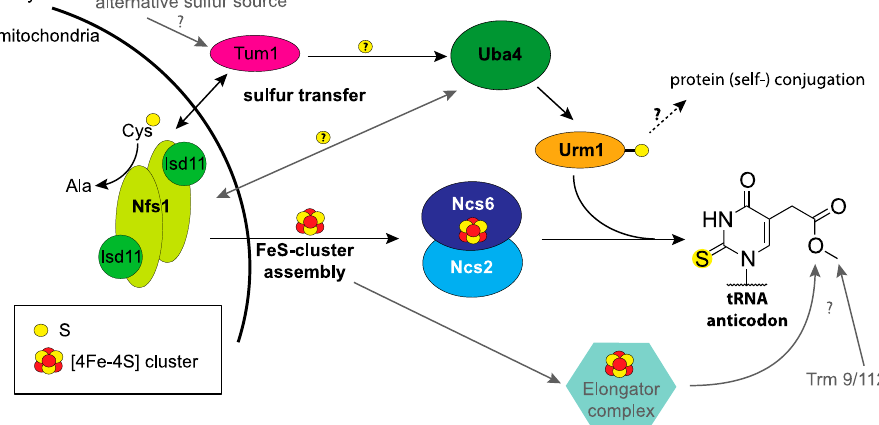
Figure 2. Biosynthetic pathway of the mcm 5 s 2 U modification. The schematic representation of the Urm1 pathway focuses on the sulfur flow (displayed as yellow balls) inside a yeast cell. Only the core components are displayed for clarity. For details see main text.